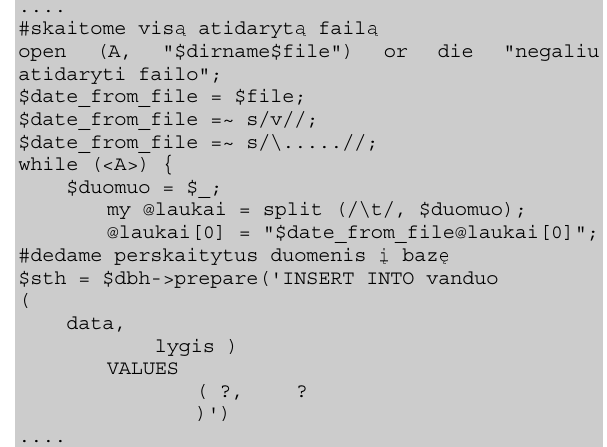
Fig 3 . Fragment of Perl script for processing the wind sensor measurements